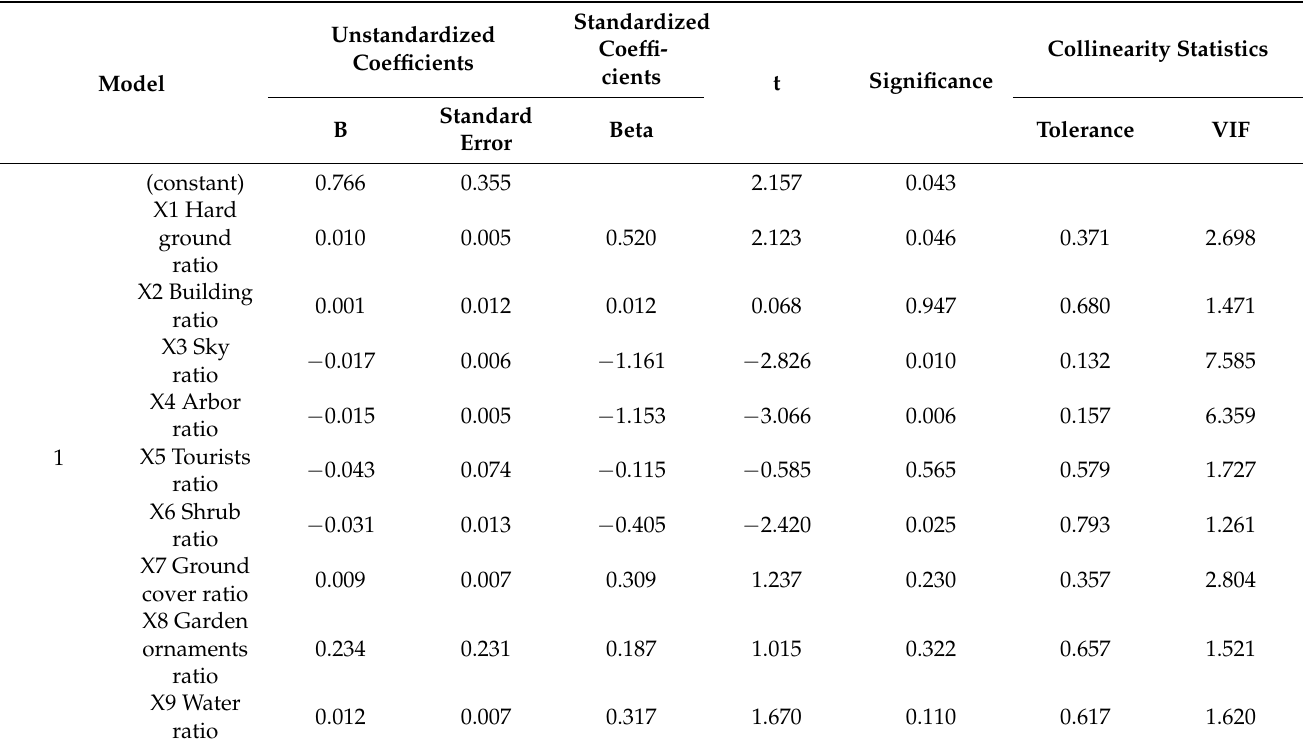
Table 4. Analysis of landscape elements affecting the PSD.